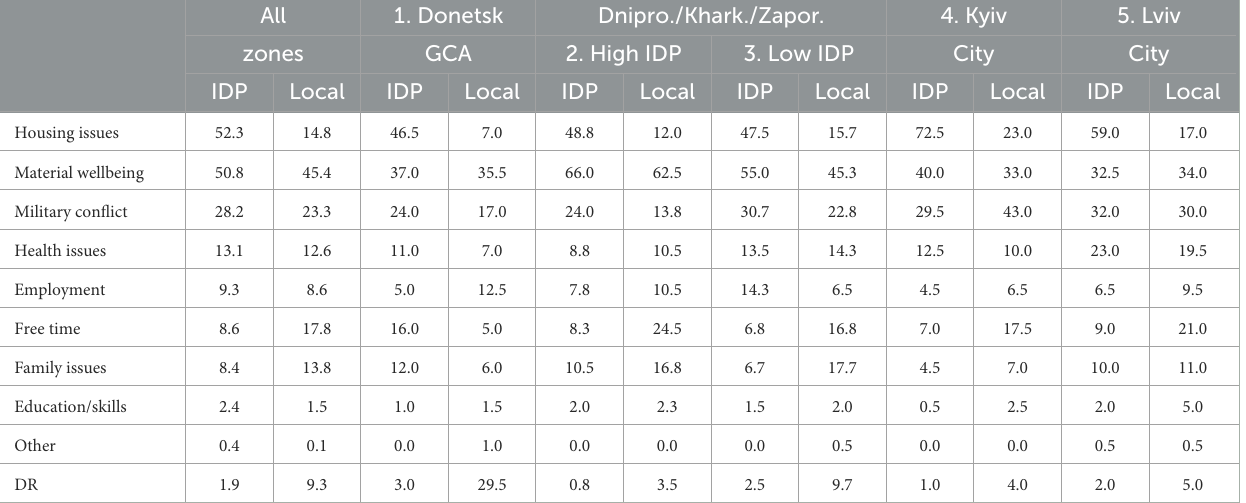
TABLE 8 Main problems identified by IDPs and locals (row